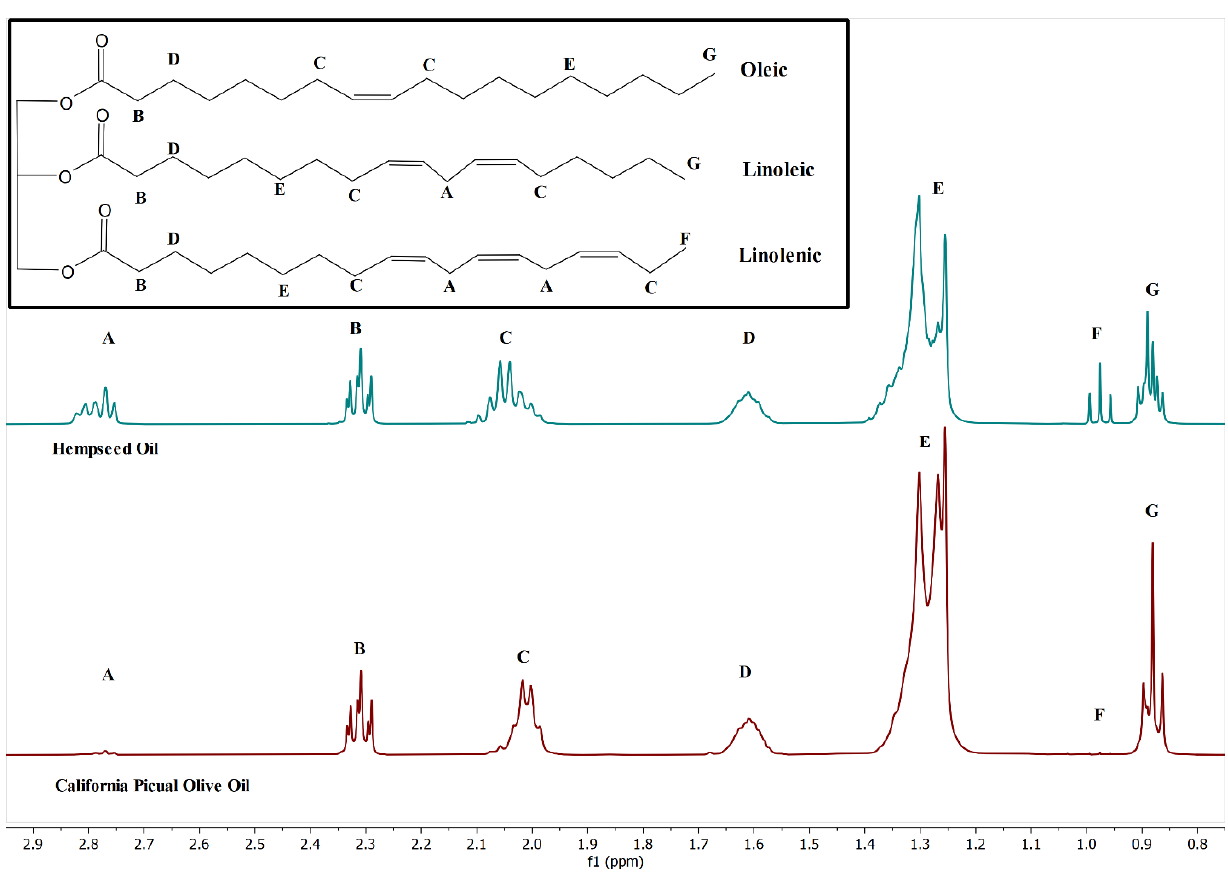
Figure 1. Comparison of 400 MHz 1 H NMR spectra of hempseed and olive oil with model triglyceride structure detailing origins of specific labeled peaks from various fatty acid subgroups.